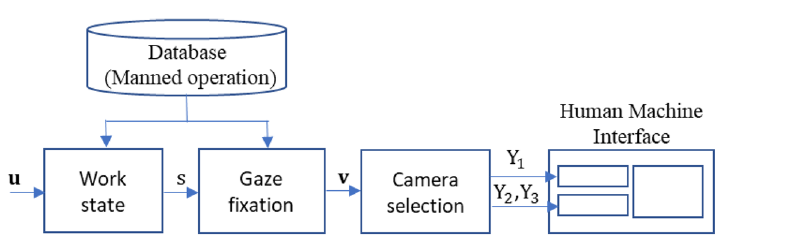
Figure 3. Configuration of the adaptive attention-based teleoperation